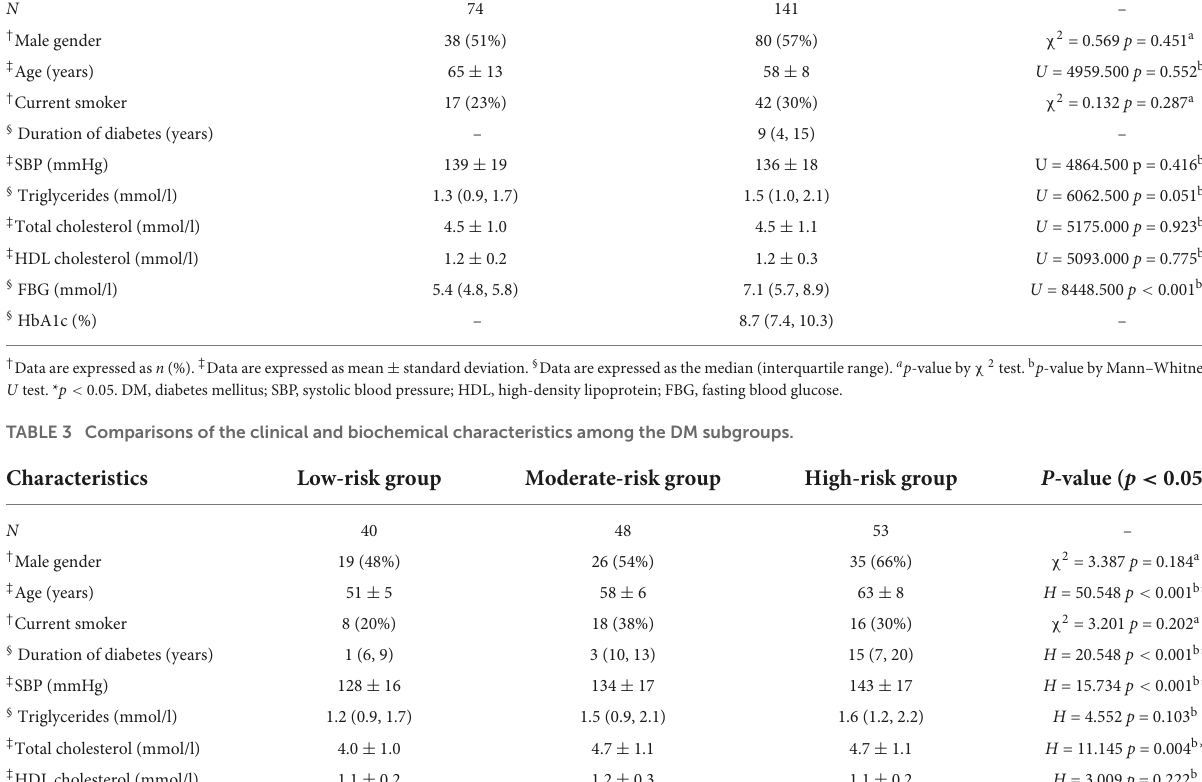
TABLE 2 Clinical and biochemical characteristics of the study population. Characteristics